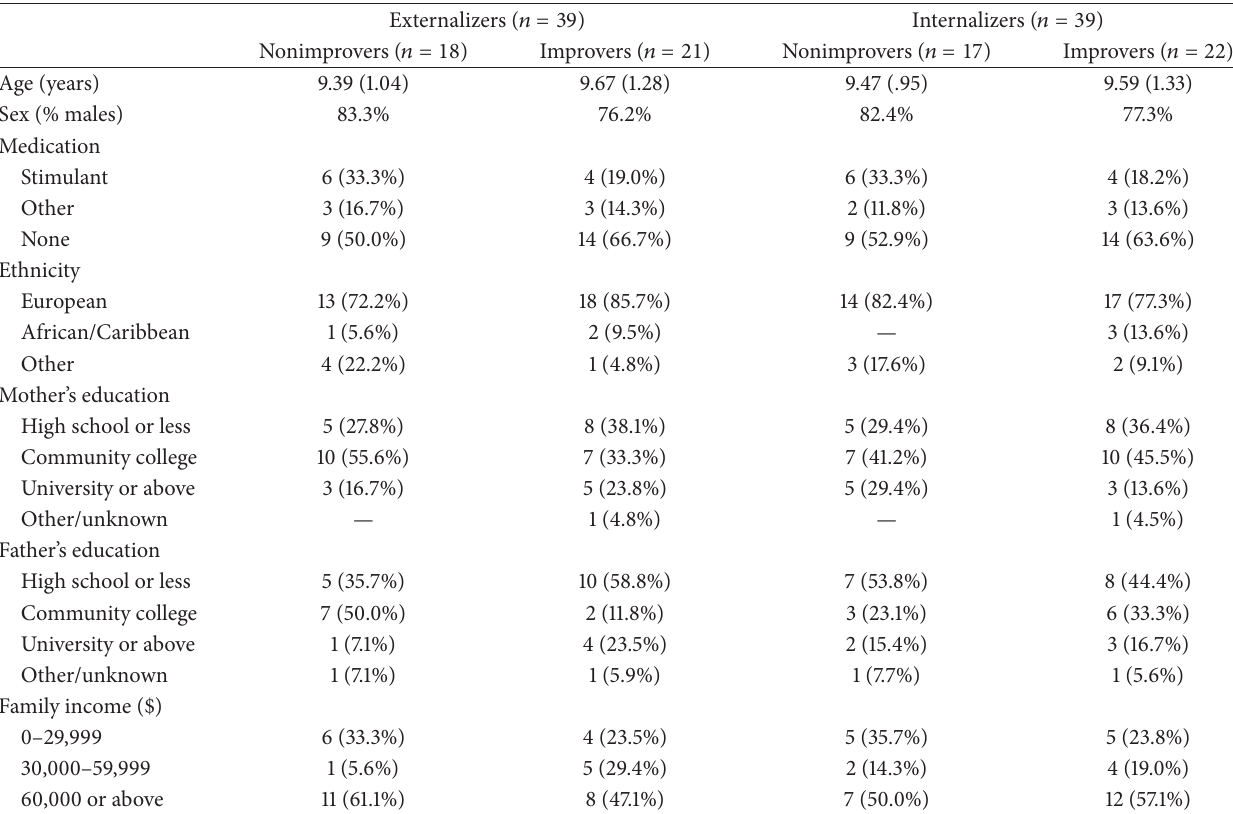
Table 1: Age, sex, medication, and demographics information broken down for IMP and NIMPs across groupings based on externalizing and internalizing